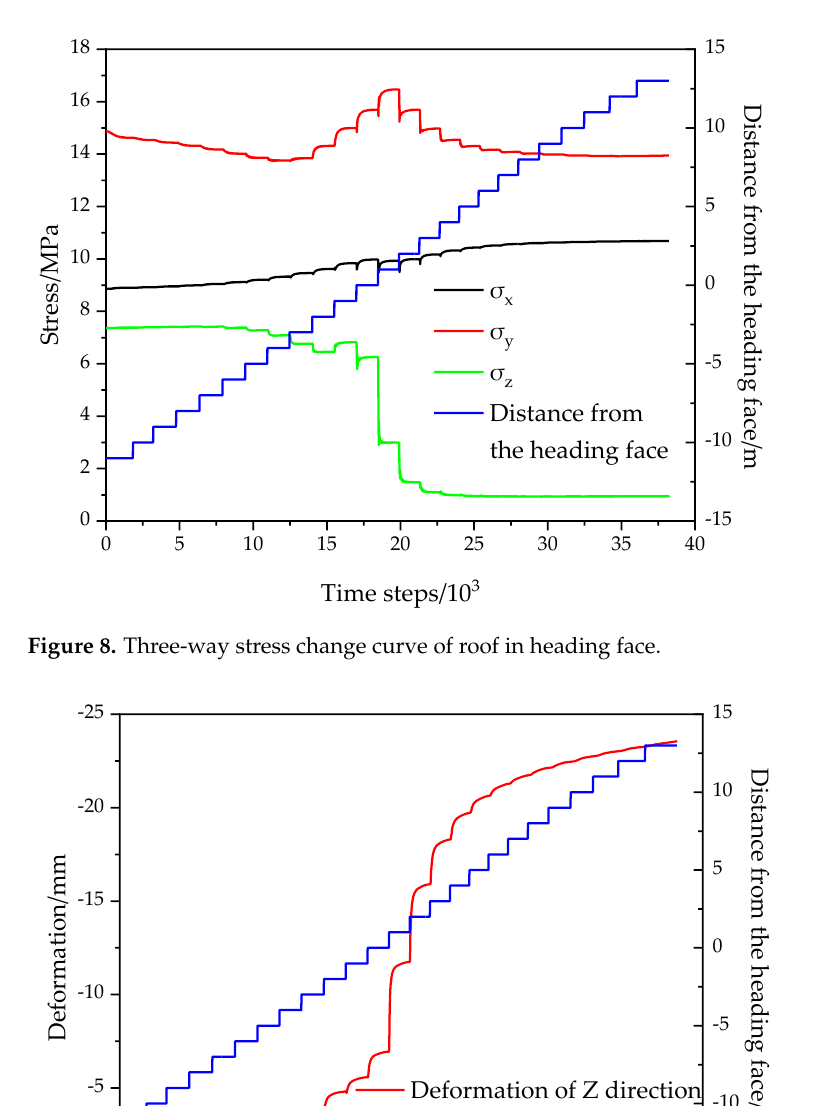
Figure 7. Displacement distribution characteristics of heading face.